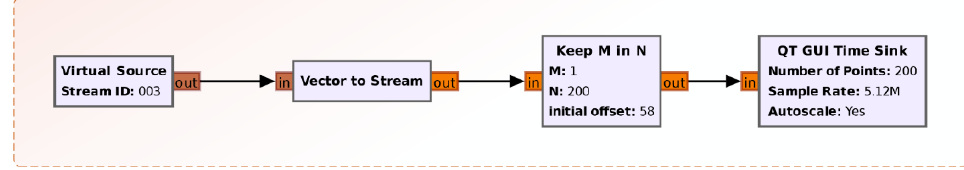
Figure 6. TETRA channel selection and the channel power display module.